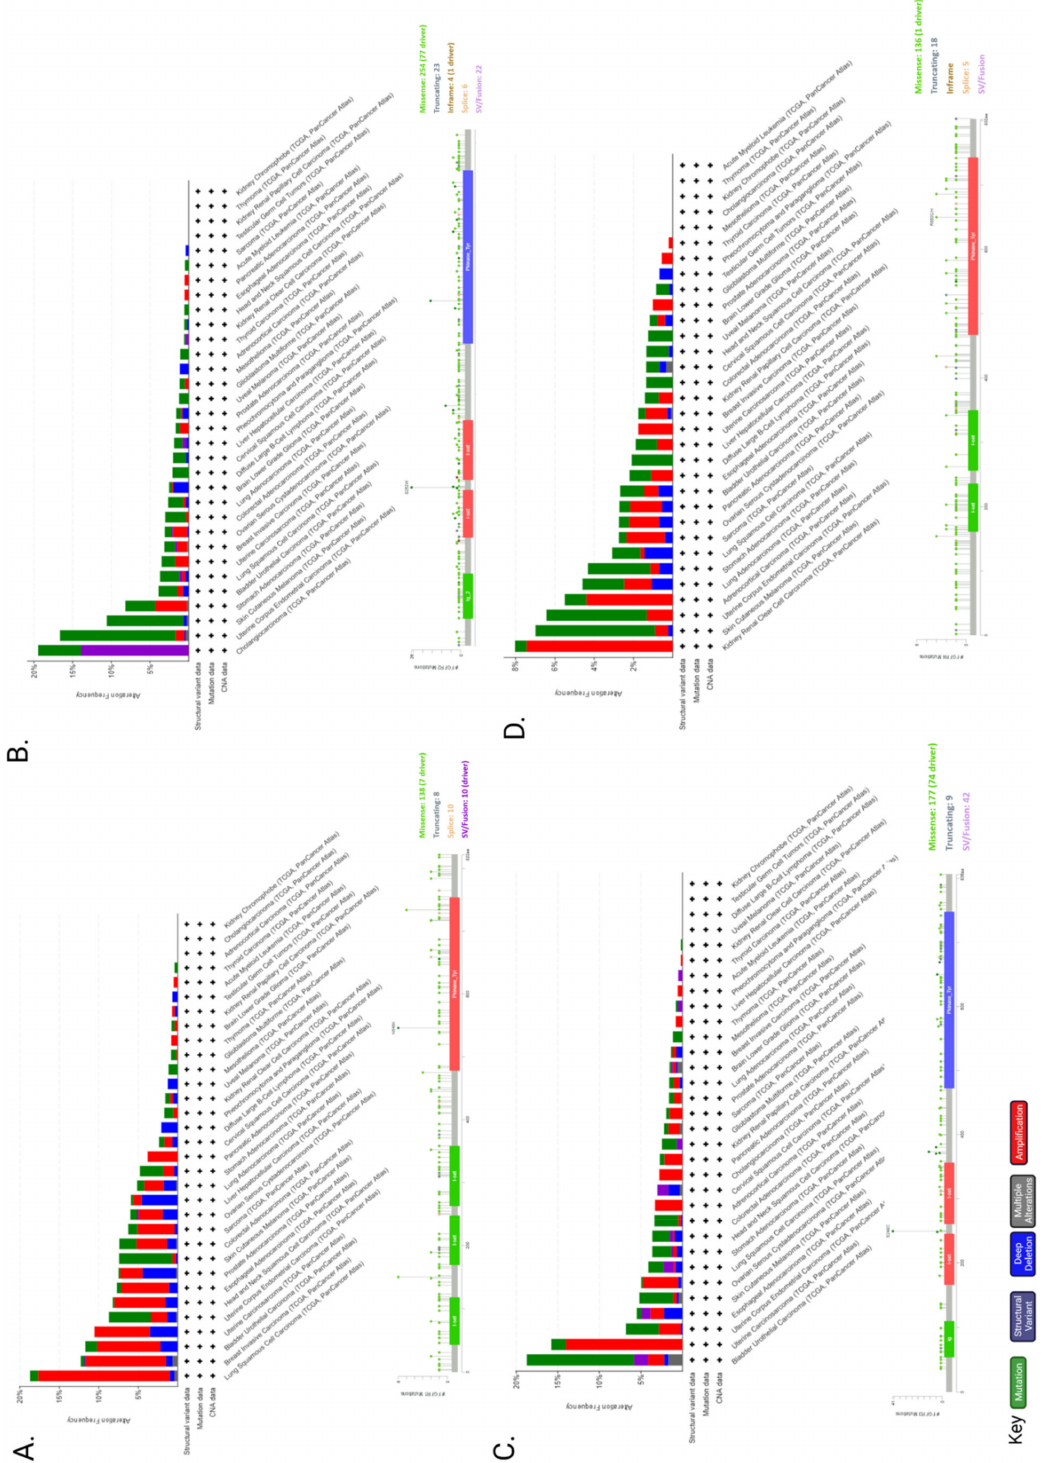
Figure 4. FGFR1–4 genetic alteration in cancer. Genetic alterations by cancer type and mutations of FGFR1 ( A ), FGFR2 ( B ), FGFR3 ( C ) and FGFR4 ( D ) were found in 662 (~6%), 360 (~3%), 351 (~3%) and 285 (~3%) patients, respectively out of 10,953 in total using cBioPortal. Mutation diagram circles and histograms are coloured with respect to the corresponding mutation types: Green = gene mutations; purple = structural variants; blue = deep deletions; grey = multiple alterations; red = gene amplifications. The lollipop diagrams of each FGF receptor (FGFR1–4), below each histogram, represent the mutation types in relation to the gene location (i.e., missense, truncating, in-frame, splice, SV/fusion). In the case of different mutation types at a single position, the colour of the circle is determined with respect to the most frequent mutation